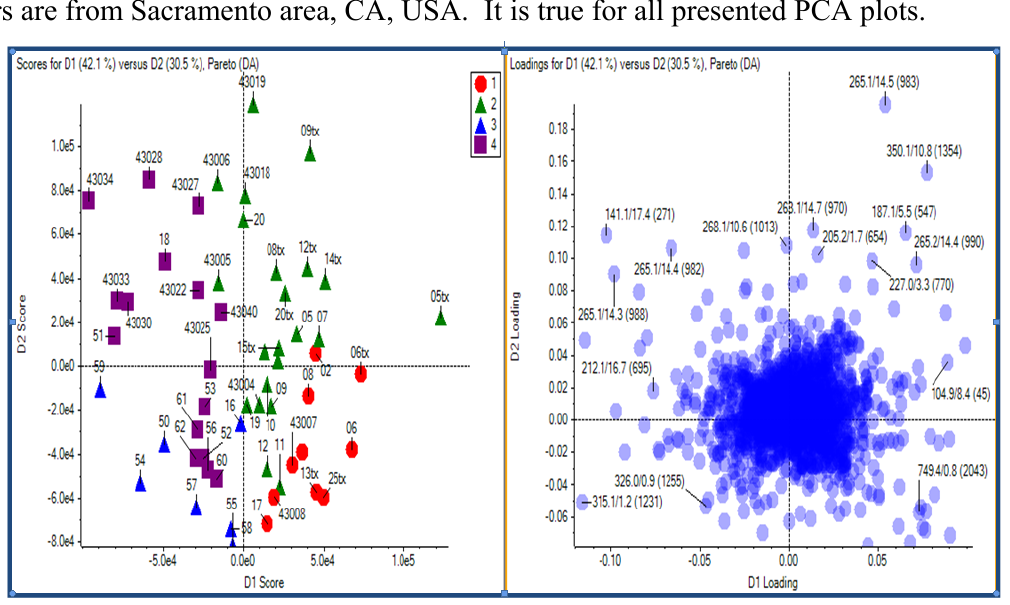
Figure 6. PCA-DA plot of the ccRCC HILIC-LC–ESI–MS before feature selection. Groups were color-coded as: 1-red: female ccRCC, 2-green: male ccRCC, 3-blue: female control, 4-purple: male control. Total of 55 samples, 2,111 predictors. Predictors (metabolites) characterized on PCA loading plots as mass to charge ratio / retention time / peak registry number. Sample number having tx extension originated from Texas, USA.